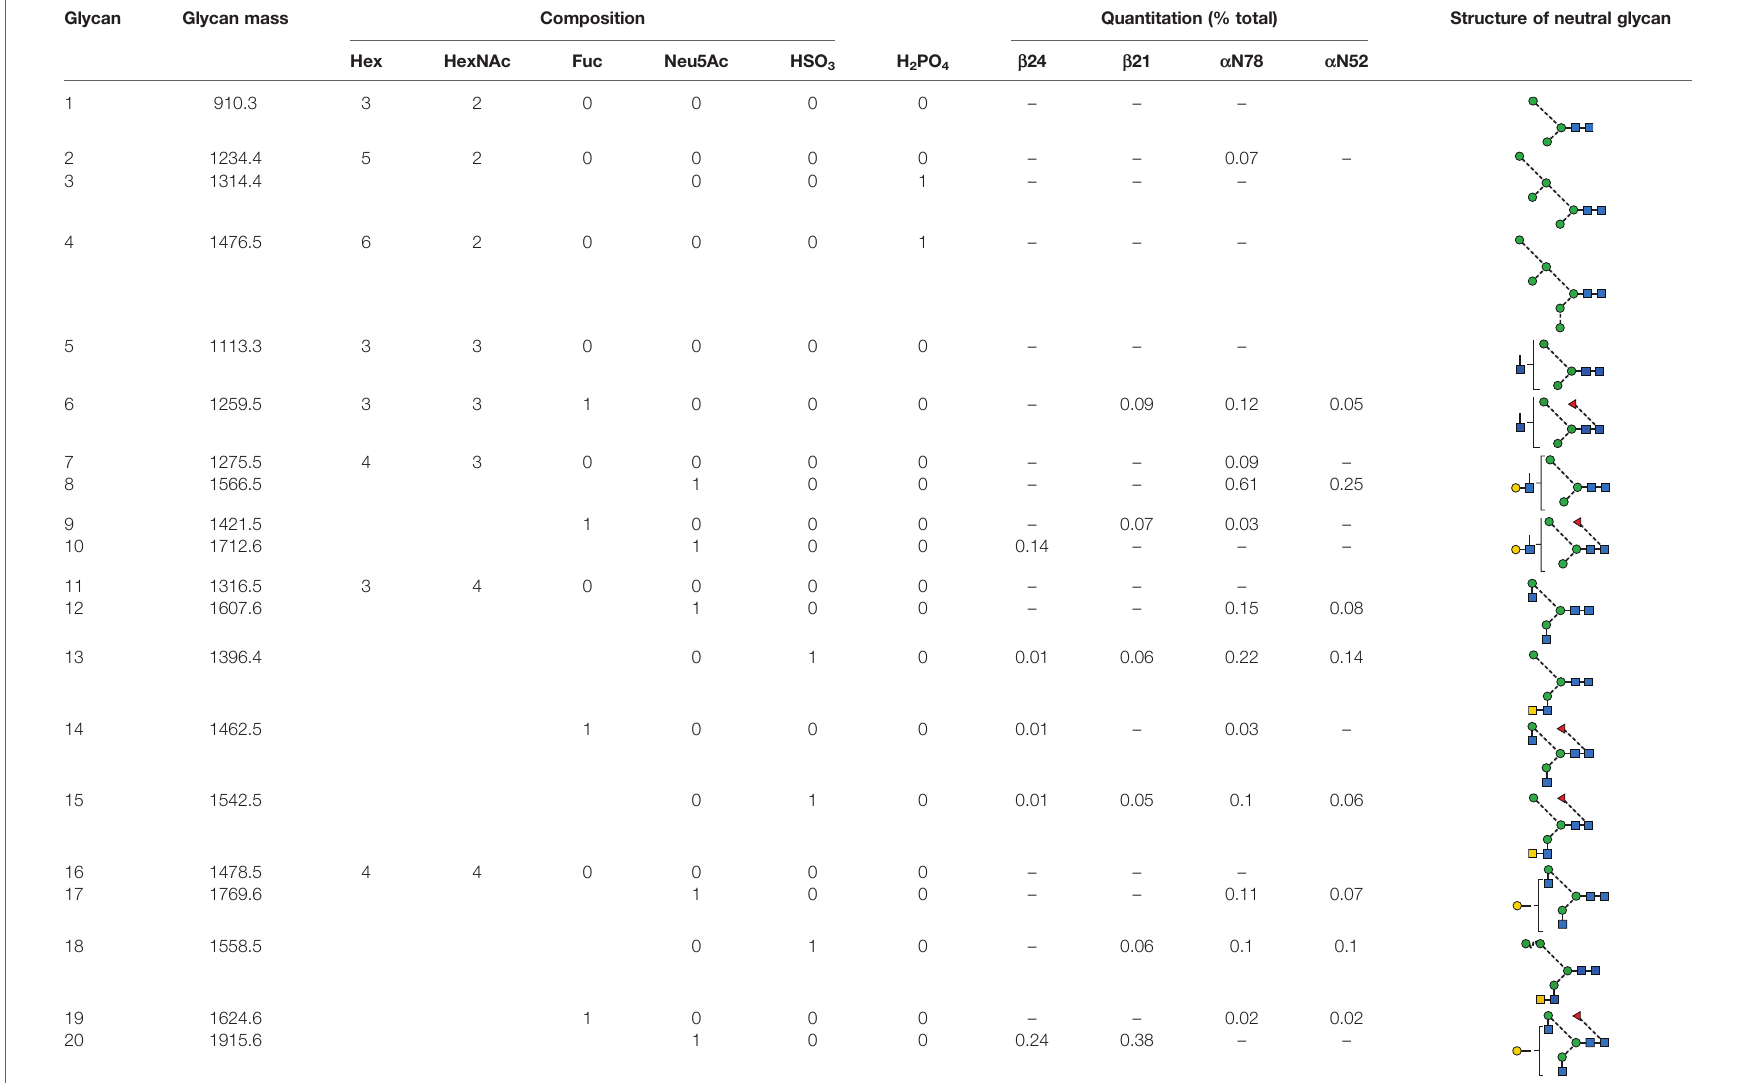
TABLE 1 | Composition and abundance of FSH glycans (all